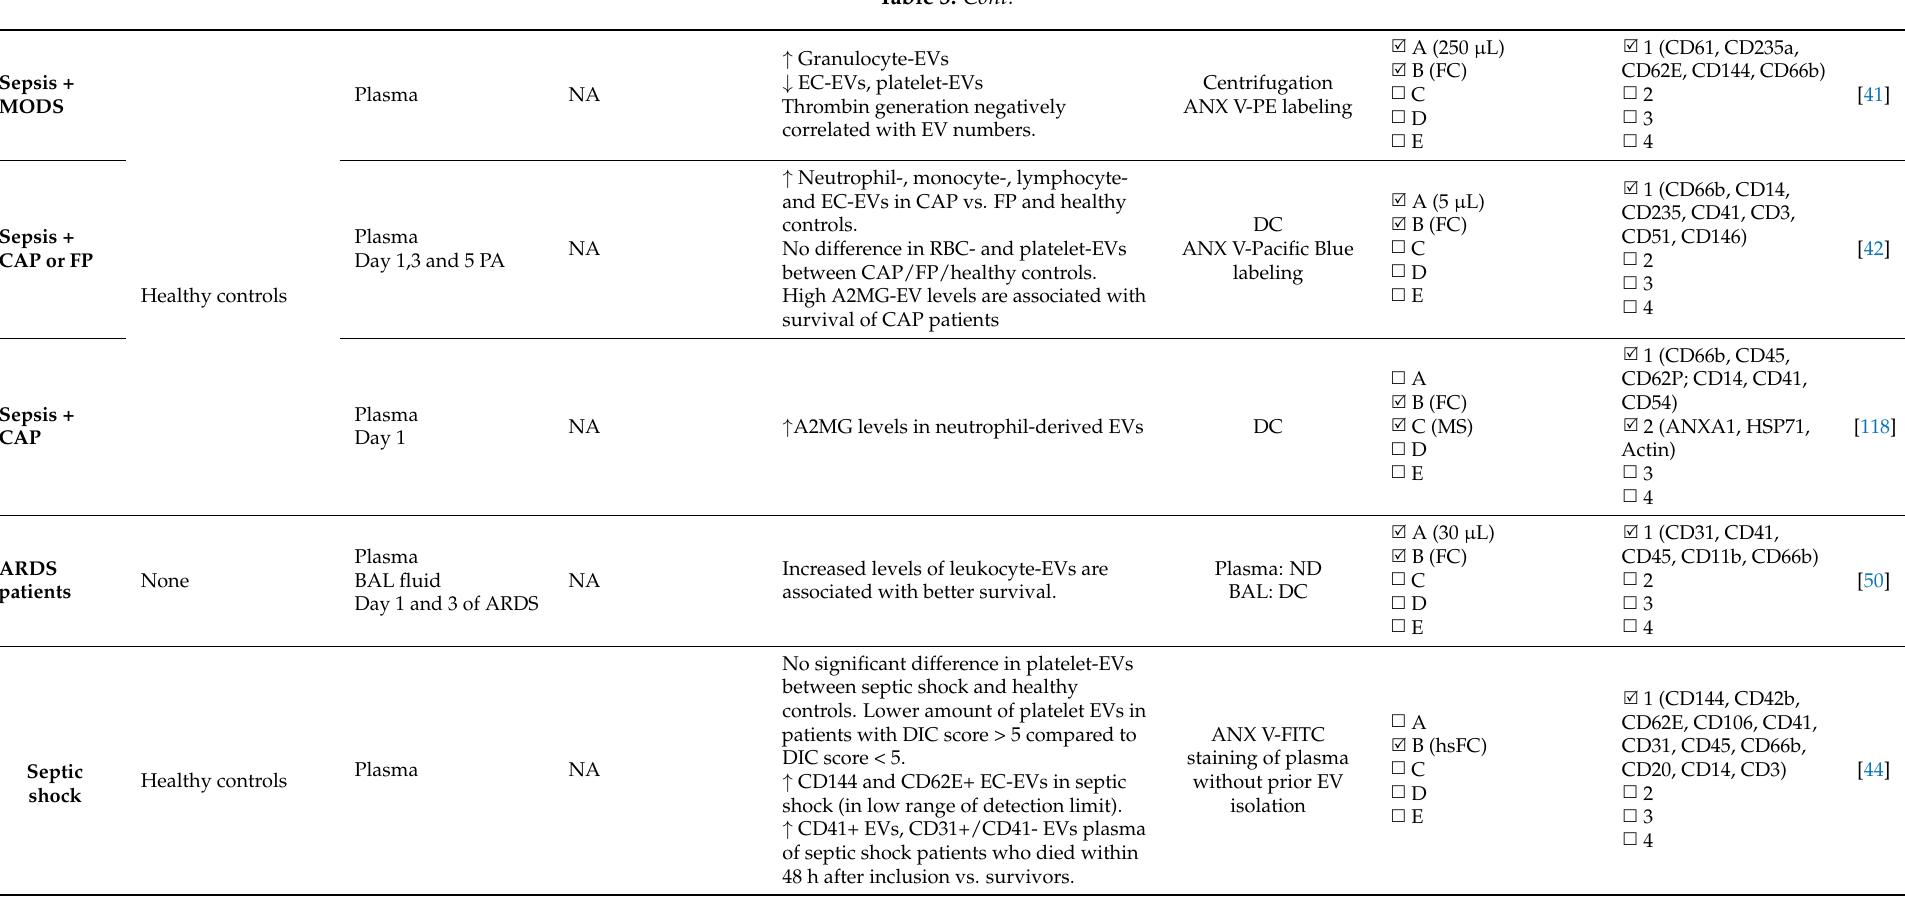
↑ PS-EVs Combination of prothrombin time, EC-derived CD105+ EVs and platelet count at D1 could predict DIC ab- sence. Total EV amount in same range for DIC and non-DIC ↑ PS-EVs patients. Combination of prothrombin time, EC-derived CD105+ Organ damage propagation via oxidative stress and in- Specific EV source pattern in DIC patients. EVs and platelet count at D1 could predict DIC ab- Organ damage propagation via oxidative stress and in- flammation: ↓ Platelet-derived EVs in DIC patients compared to Heart: ↑ COX1, COX2, SOD, eNOS. flammation: non-DIC patients Heart: ↑ COX1, COX2, SOD, eNOS. Lungs: COX-2, NF κ B levels affected. ↑ EC-EVs and leukocyte EVs in DIC (D1) Liver: ↓ eNOS, manganese SOD. Lungs: COX-2, NF κ B levels affected. ↑ Leukocyte- EVs in DIC at D7 Liver: ↓ eNOS, manganese SOD.